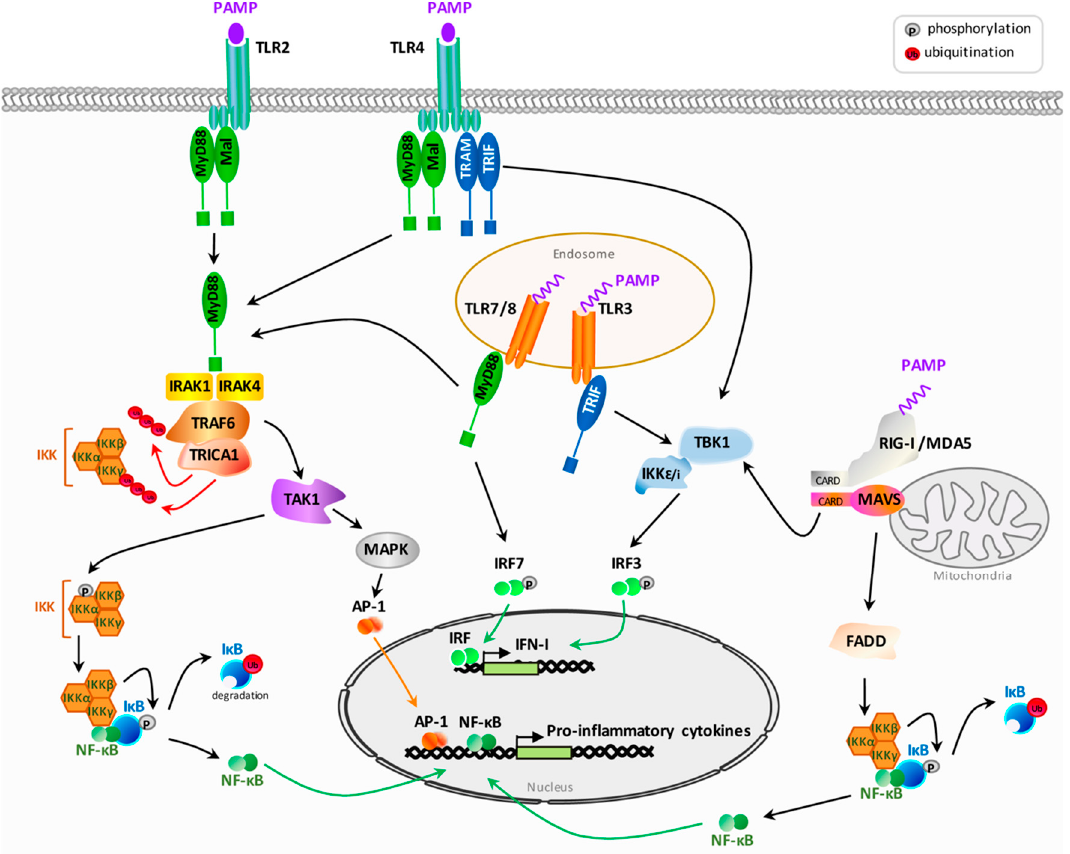
Figure 1. Simplified overview of several pattern recognition receptors (PRRs) signaling after pathogen-associated-molecular patterns (PAMPs) recognition. Signal transduction cascades leading to the production of type I interferon (IFN-I) and pro-inflammatory cytokines after Toll-like-receptors (TLRs) and retinoic acid-inducible gene I (RIG-I)-like receptors (RLRs) activation are described. See the text for more details. MyD88: myeloid differentiation factor 88, MAL: MyD88-adaptor-like, TRIF: TIR domain-containing adaptor-inducing IFN- β , TRAM : TRIF-related adaptor molecule, IRAK: interleukin-1 receptor-associated kinase, TRAF6: TNF receptor associated factor 6, TAK1: transforming growth factor beta-activated kinase 1, MAPK: mitogen-activated protein kinase, IKK: I κ B kinase, NF- κ B: nuclear factor-kappa B, IRF: IFN-regulatory factor, TBK1: tank-binding kinase 1, MAVS: mitochondrial antiviral-signaling, FADD: Fas-associated protein with death